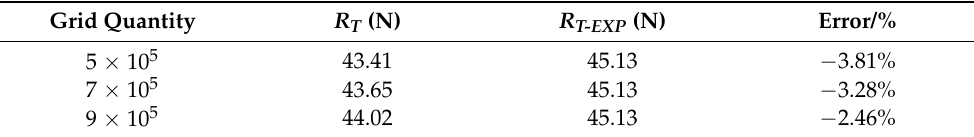
Table 7. Comparison of calculated resistance and experimental Value ( Fr = 0.28). Grid Quantity